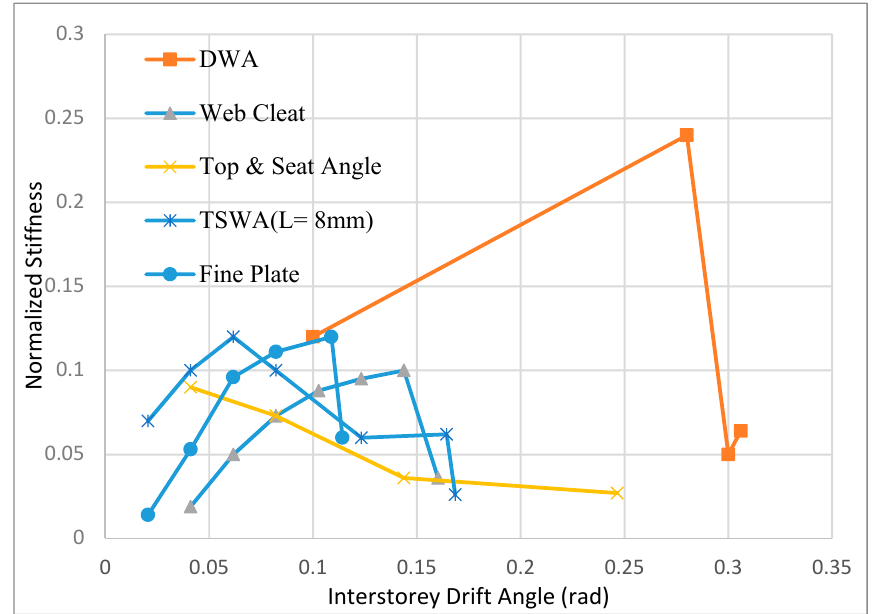
Figure 19. Stiffness degradation versus inter-storey drift angle for flexible connections.